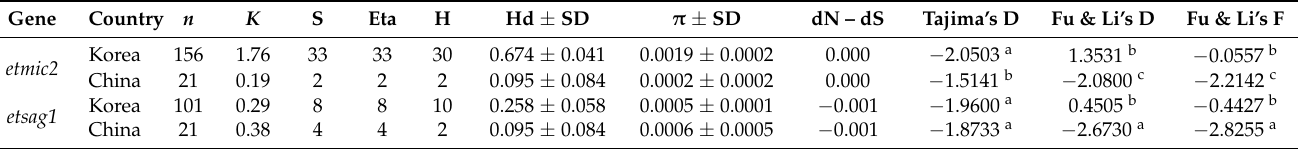
Table 1. Genetic polymorphism and tests of neutrality in the etmic2 and etsag1 of Korean and Chinese E. tenella isolates.